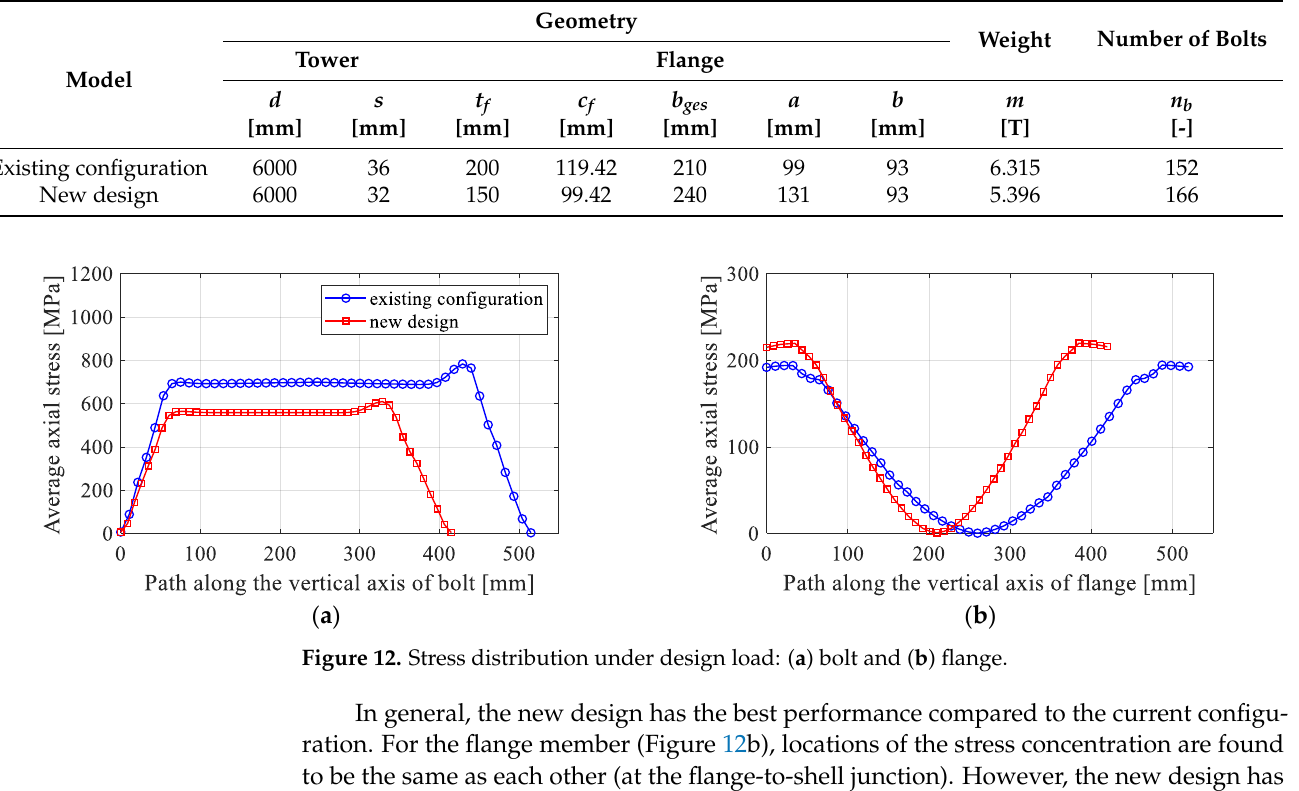
Table 5. Comparison of existing configuration and new design.